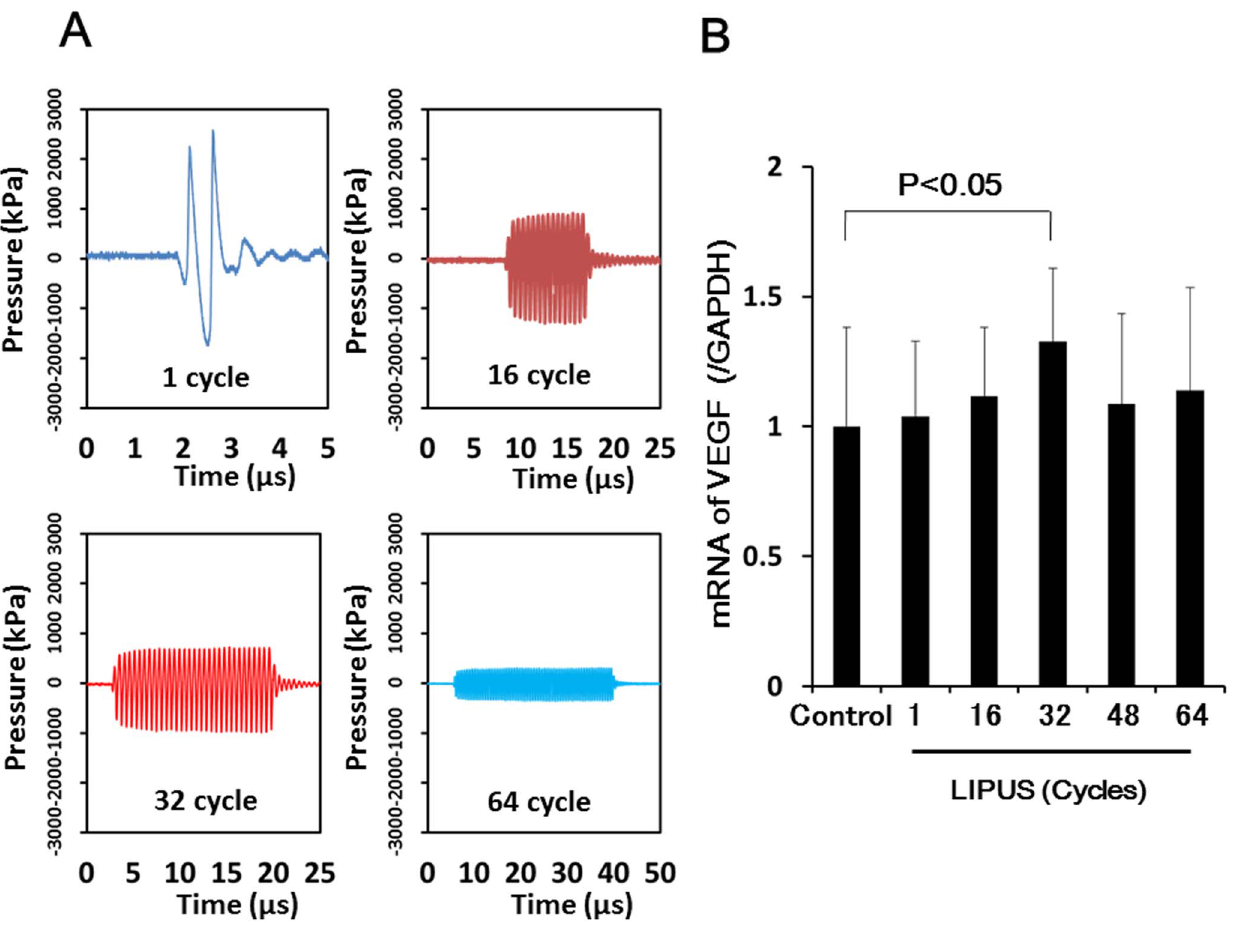
Figure 1. In vitro study. ( A ) Acoustic pressure at various cycle numbers. ( B ) LIPUS treatment up-regulated mRNA expression of VEGF in HUVECs in vitro with a maximum effect noted at 32-cycle. Results are expressed as mean 6 SEM (n=9–11 each).